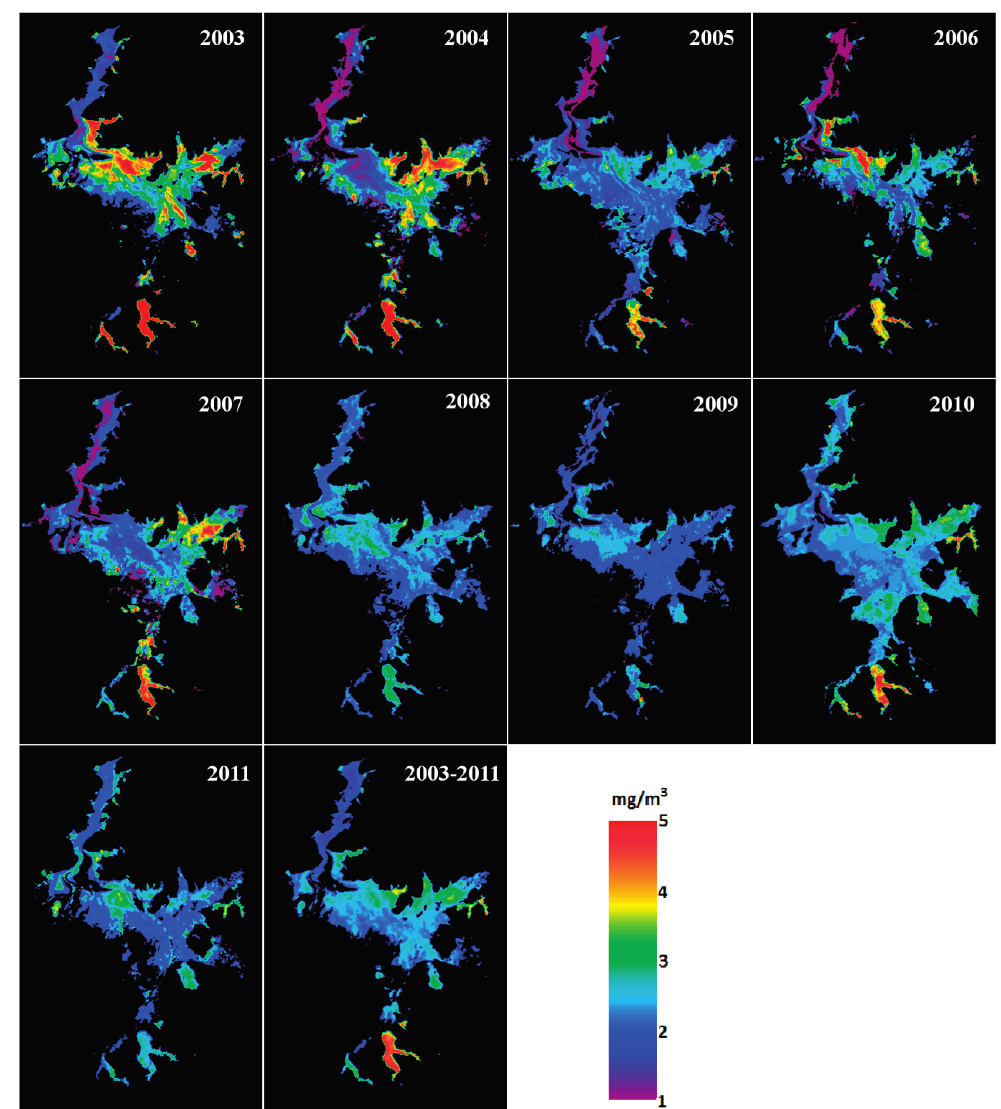
Figure 9. Mean Chl-a distributions of Poyang Lake between July and September, during which the lake inundation and Chl-a reached the maxima) for each year between 2003 and 2011. The last panel shows the summer mean during the nine-year